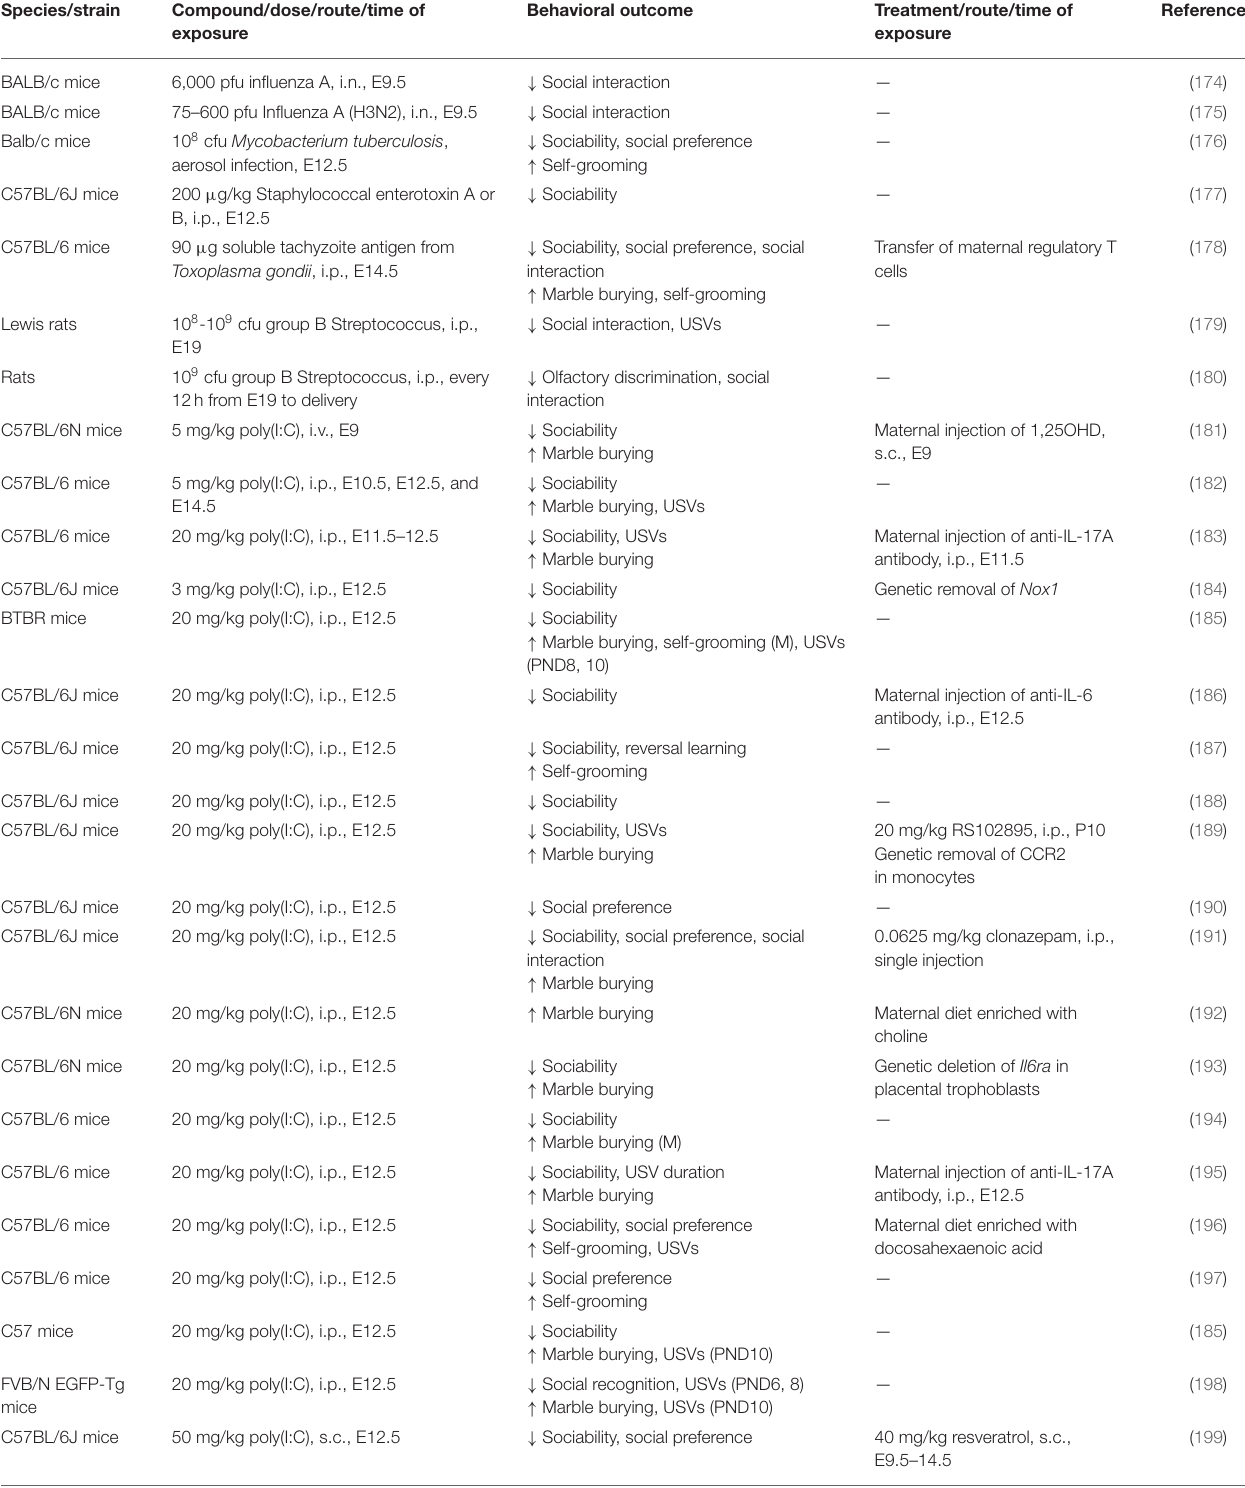
TABLE 3 | Maternal immune activation models of ASD in